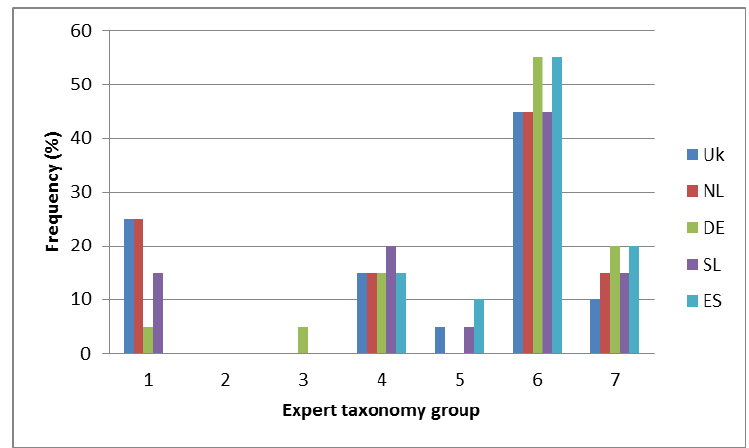
Figure A1. Frequency of structured sort placement of nutrition claims per country—‘Rich in vitamin C’ (Card 19).